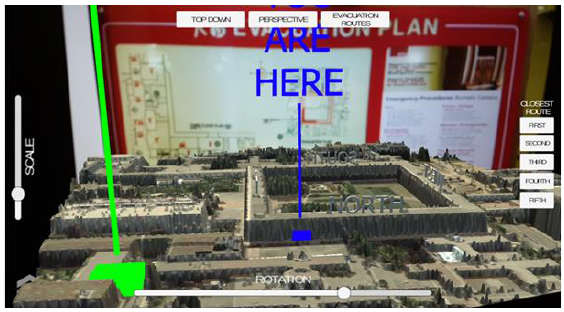
Figure 6. AR evacuation plan visualization (off-nadir)